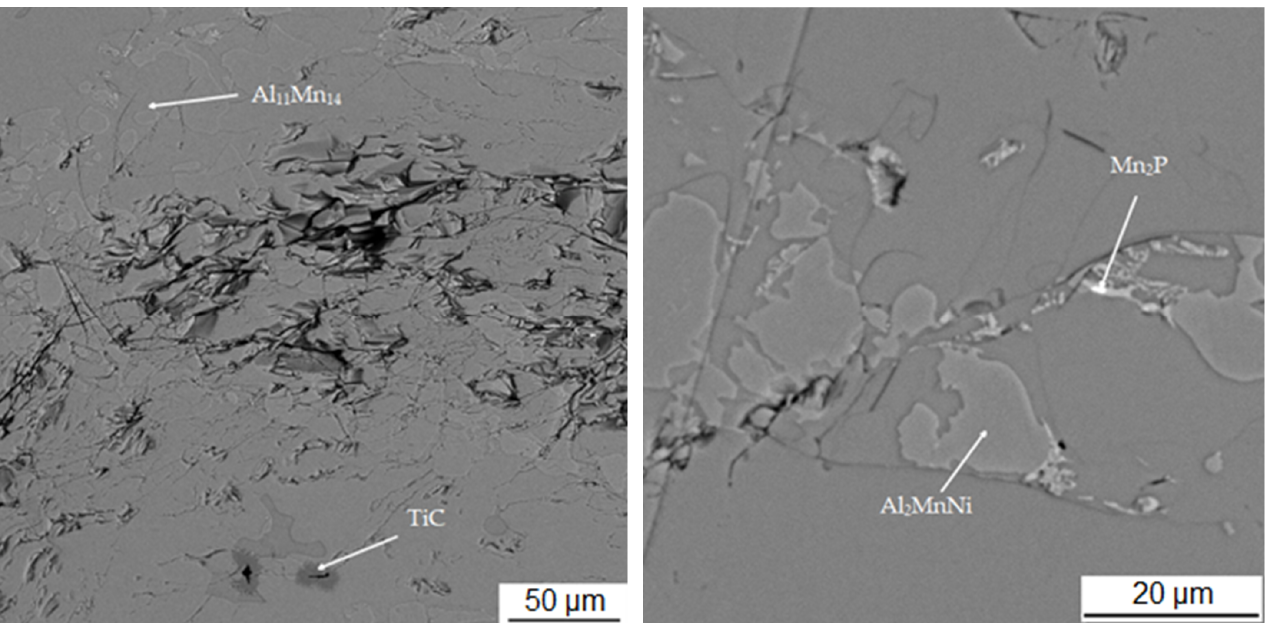
Figure 3. Microstructure of sample with 100% excess of aluminum over stoichiometry in the reduced state.